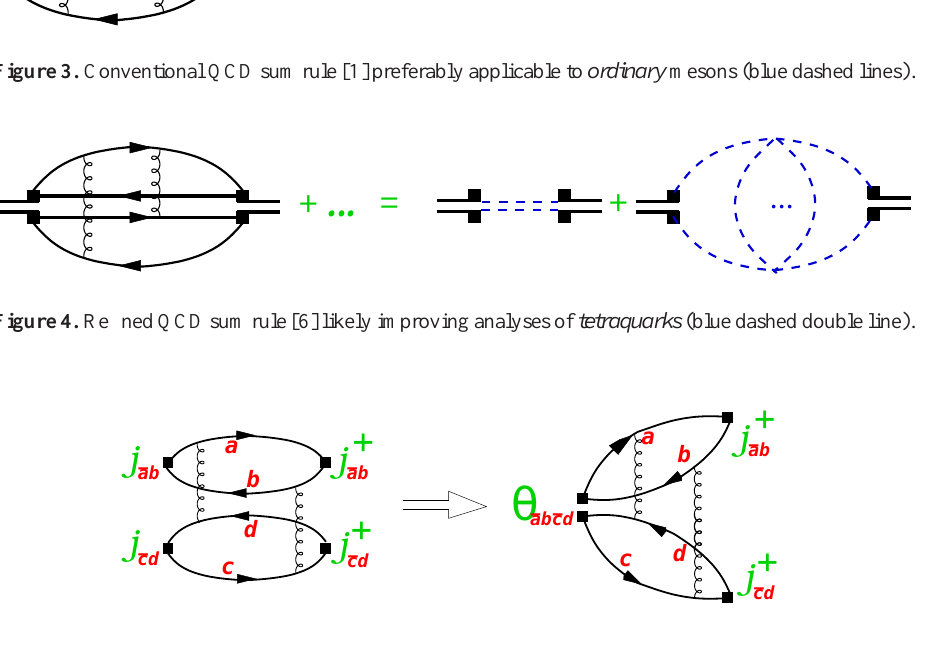
Figure 5. Flavour- retaining correlation function [6]: typical lowest-order tetraquark-phile contribution, subject to a single contraction to a tetraquark-interpolating operator, leaving two quark-bilinear